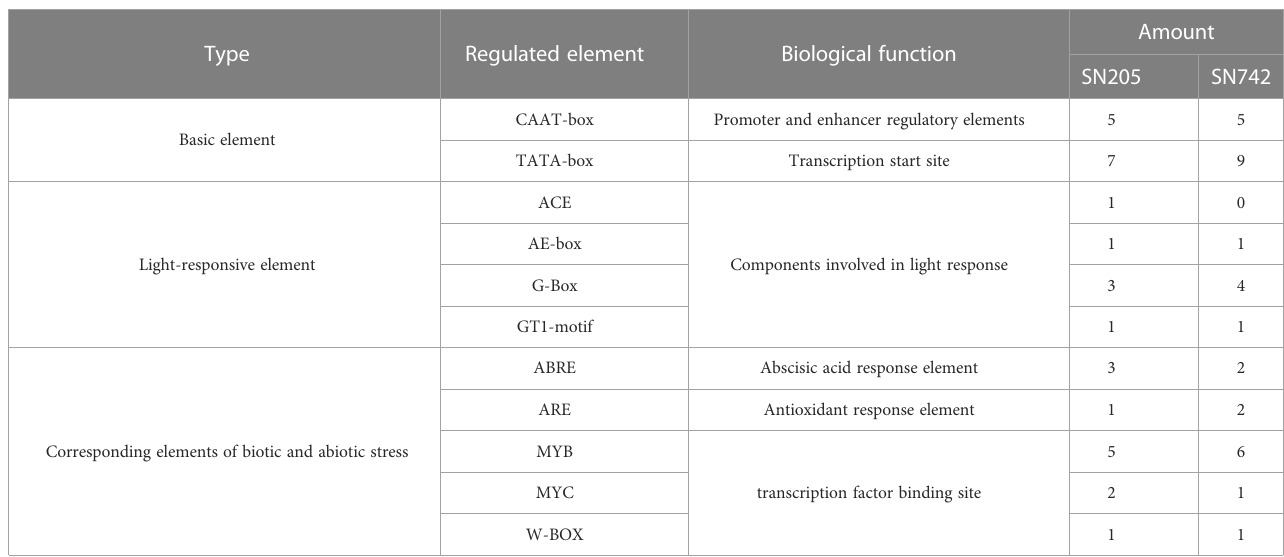
TABLE 2 Promoter element analysis of BrRPP1 in resistance and susceptible materials of Chinese